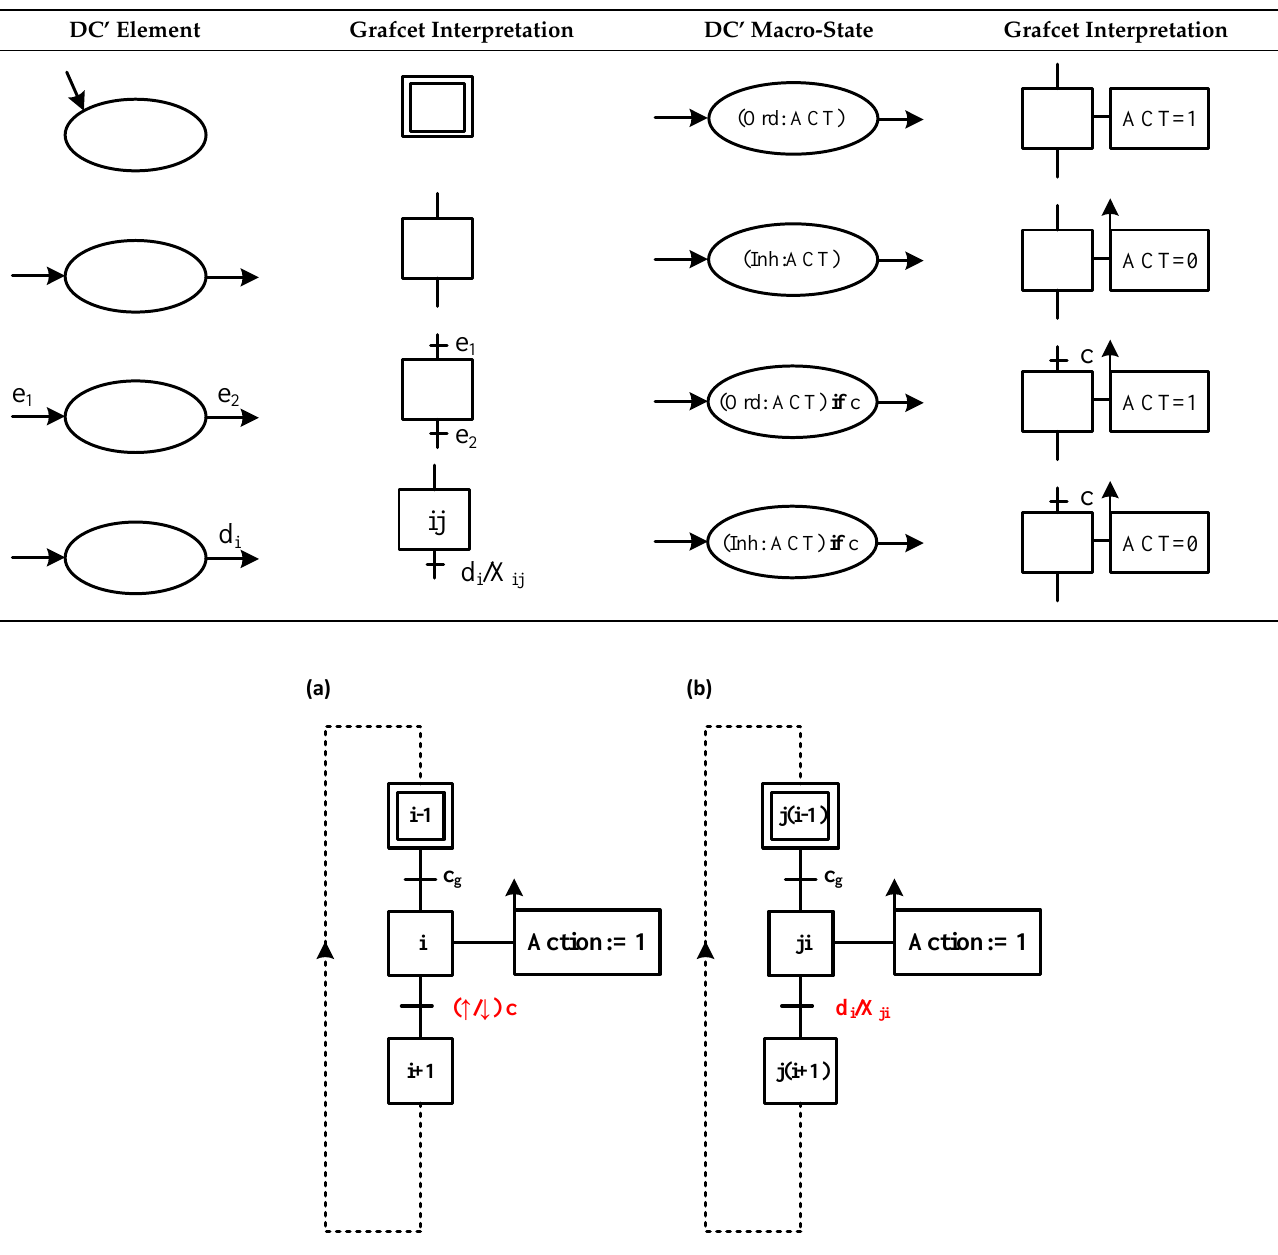
Table 2. Interpretation rules.